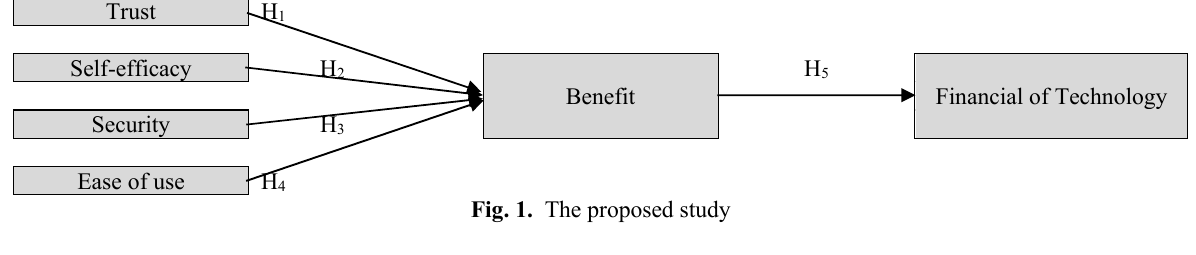
Fig. 1. The proposed